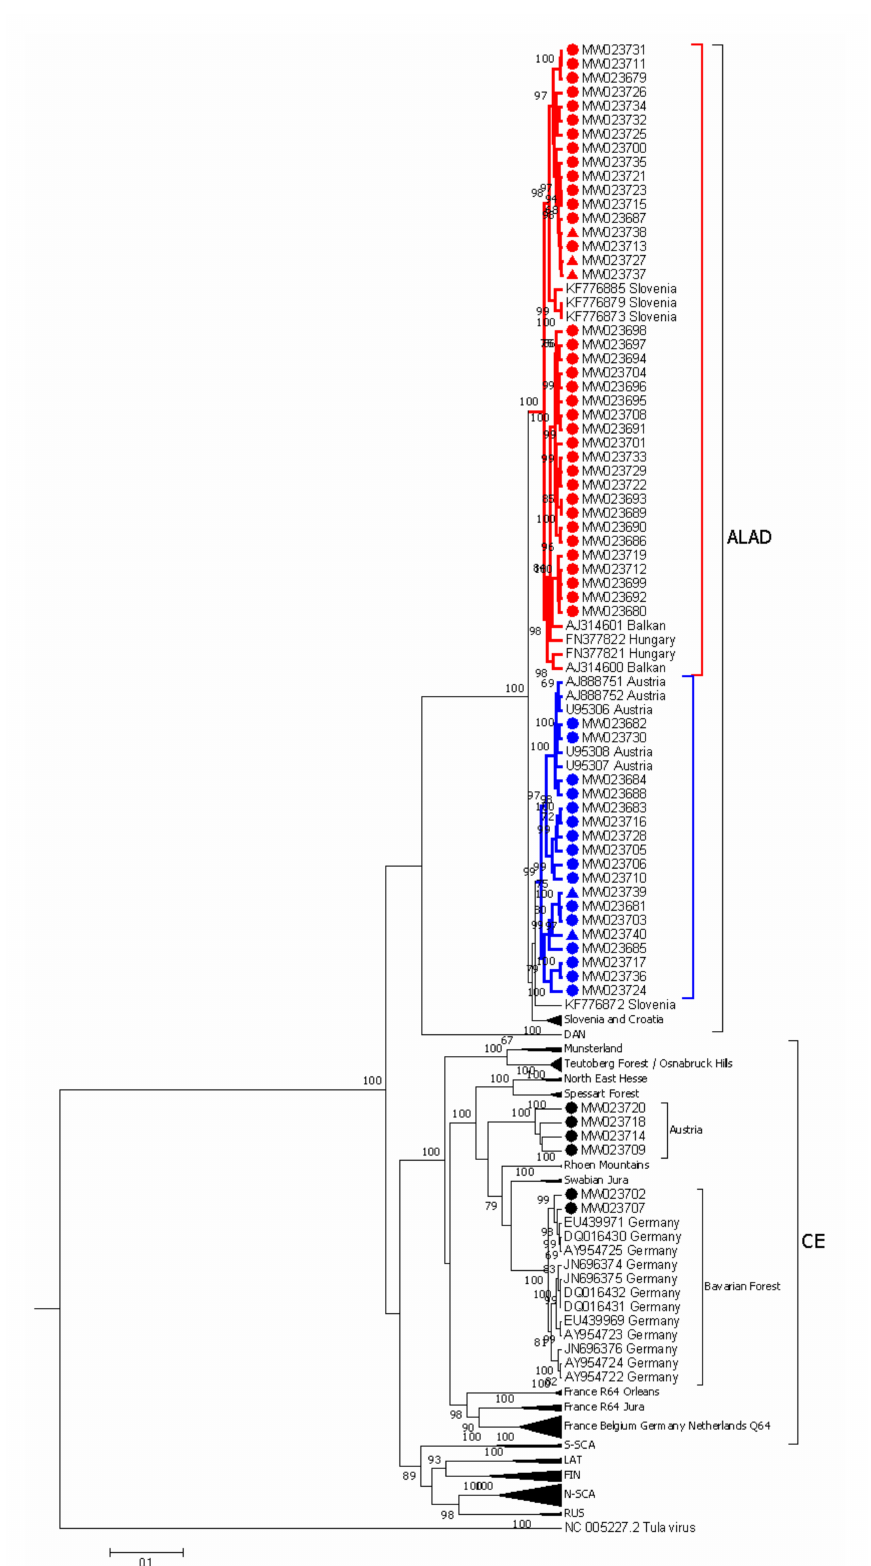
Figure 3. Phylogenetic tree (maximum clade credibility) of partial Puumala orthohantavirus (PUUV) S segment sequences (505 nt) from across Europe. Sequences derived from human patients (filled circles) or Clethrionomys glareolus (filled triangles) in Austria (labelled with GenBank Accession numbers) are compared to previously published sequences from C. glareolus (labelled with GenBank Accession